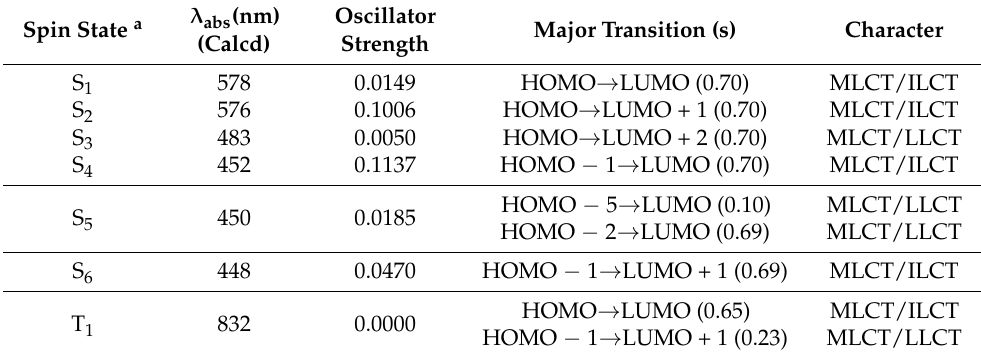
Table 2. TD-DFT calculation of representative excitation state and transition assignment of complex 4